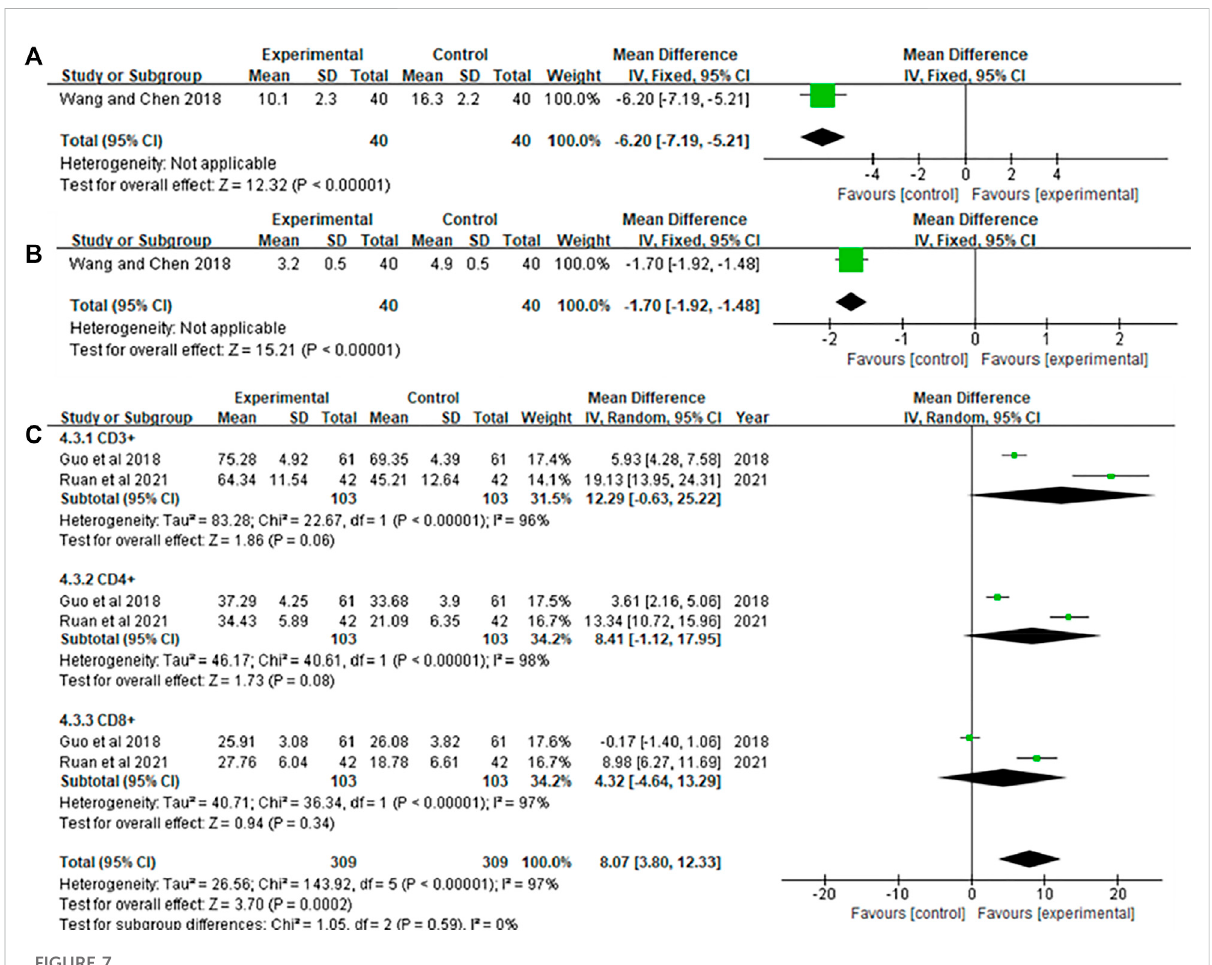
FIGURE 7 Meta-analysis of immune function. (A) MDSCs; (B) Treg; (C) CD3 + , CD4 + , and CD8 +